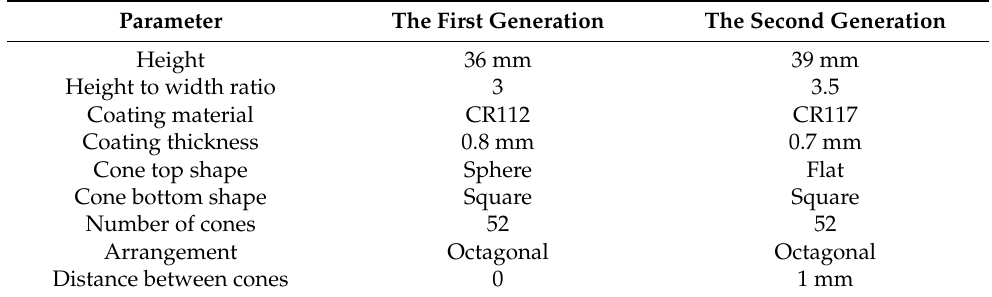
Table 1. Structure parameters of two generations of blackbody calibration source